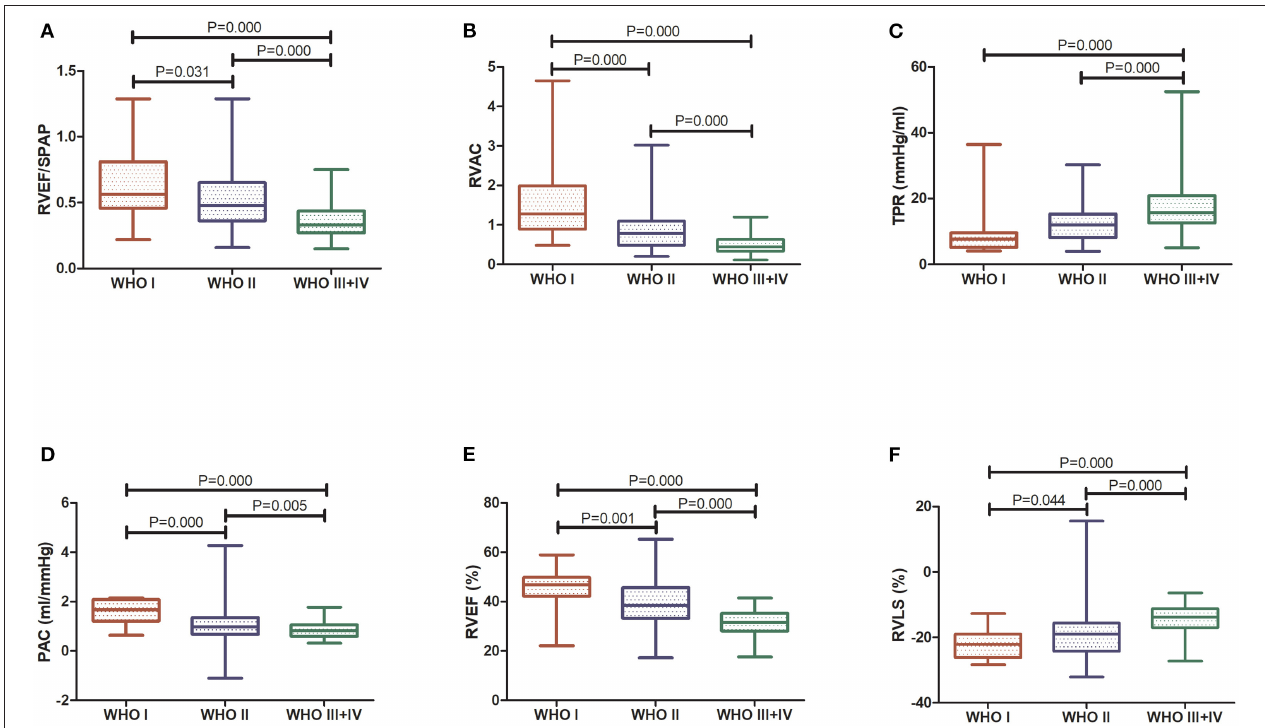
FIGURE 2 | Comparison of RV function indices and RV coupling to pulmonary circulation among WHO-FC groups. (A) RVEF/PASP; (B) RVAC; (C) TPR; (D) PAC; (E) 3D RVEF; and (F)